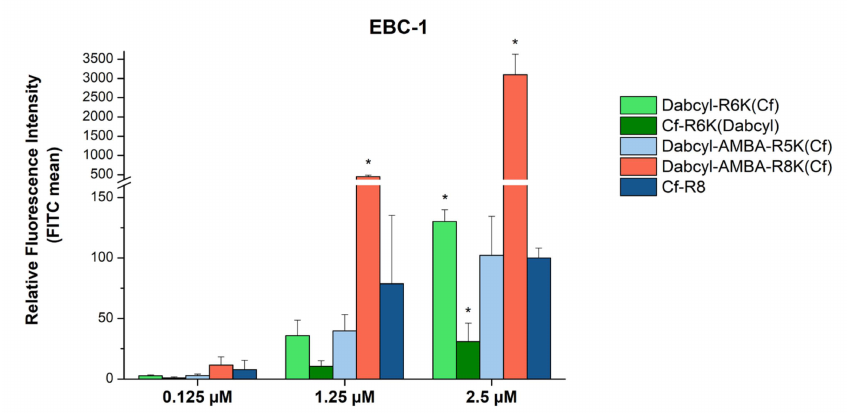
Figure 4. Cellular uptake of selected peptides by EBC-1 cells. The cells were treated with 0.125, 1.25 and 2.5 µ M peptide solutions at 37 ◦ C for 90 min. After trypsinization the fluorescence intensity of the cells was studied using flow cytometry. The fluorescence intensities were normalized to the fluorescence intensity of cells that were treated with Cf-Arg 8 at a concentration of 2.5 µ M (100%). Any significant difference from octaarginine control of a given concentration was measured using the Student’s t test (* p <